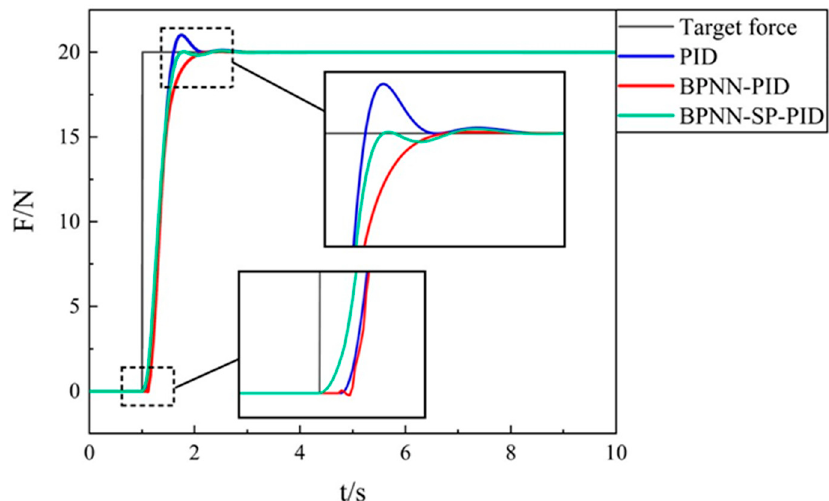
Figure 12. Comparison of step responses of the three controllers in the simulation.